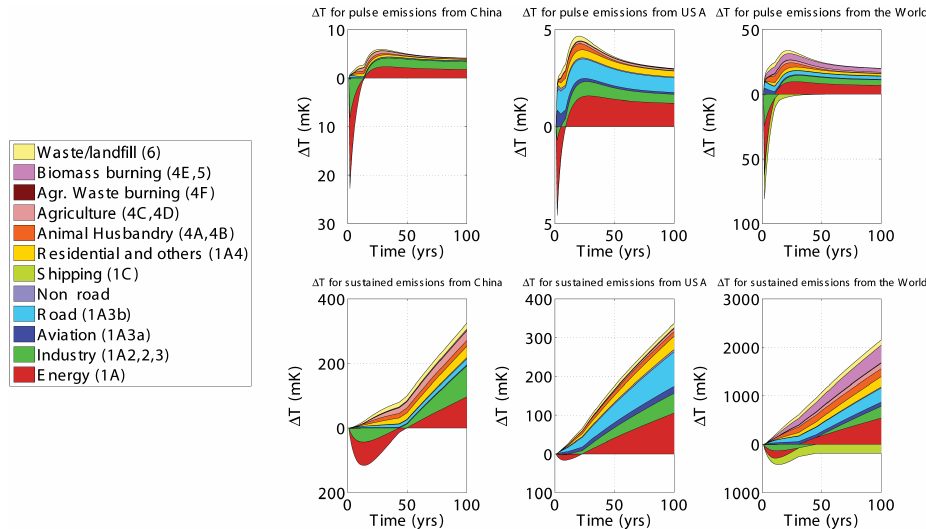
Fig. 11. The estimated temperature perturbation based on AGTP for different sectors due to EDGAR 2008 emissions. The net result (sum of all sectors) is found Fig. 10.